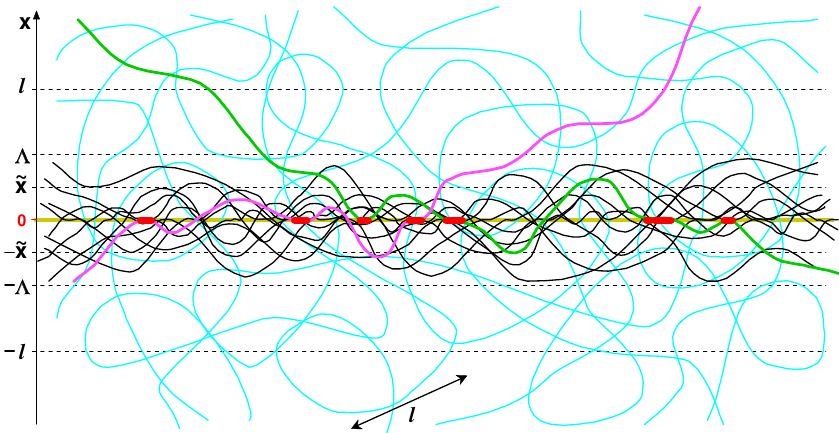
Figure 4. The structure of loops formed by a wormlike chain near a penetrable membrane at a near-critical adsorption strength, u ≈ u ∗ , u < u ∗ . There are long semiflexible isotropic loops (shown in cyan) everywhere, while shorter aligned loops (shown in black) are present only close enough to the membrane. Aligned loops show a fractal distribution for | x | (cid:46) Λ , and they dominate by mass in the proximal layer at | x | (cid:46) ˜ x , where ˜ x < Λ . The aligned loops virtually merge with long